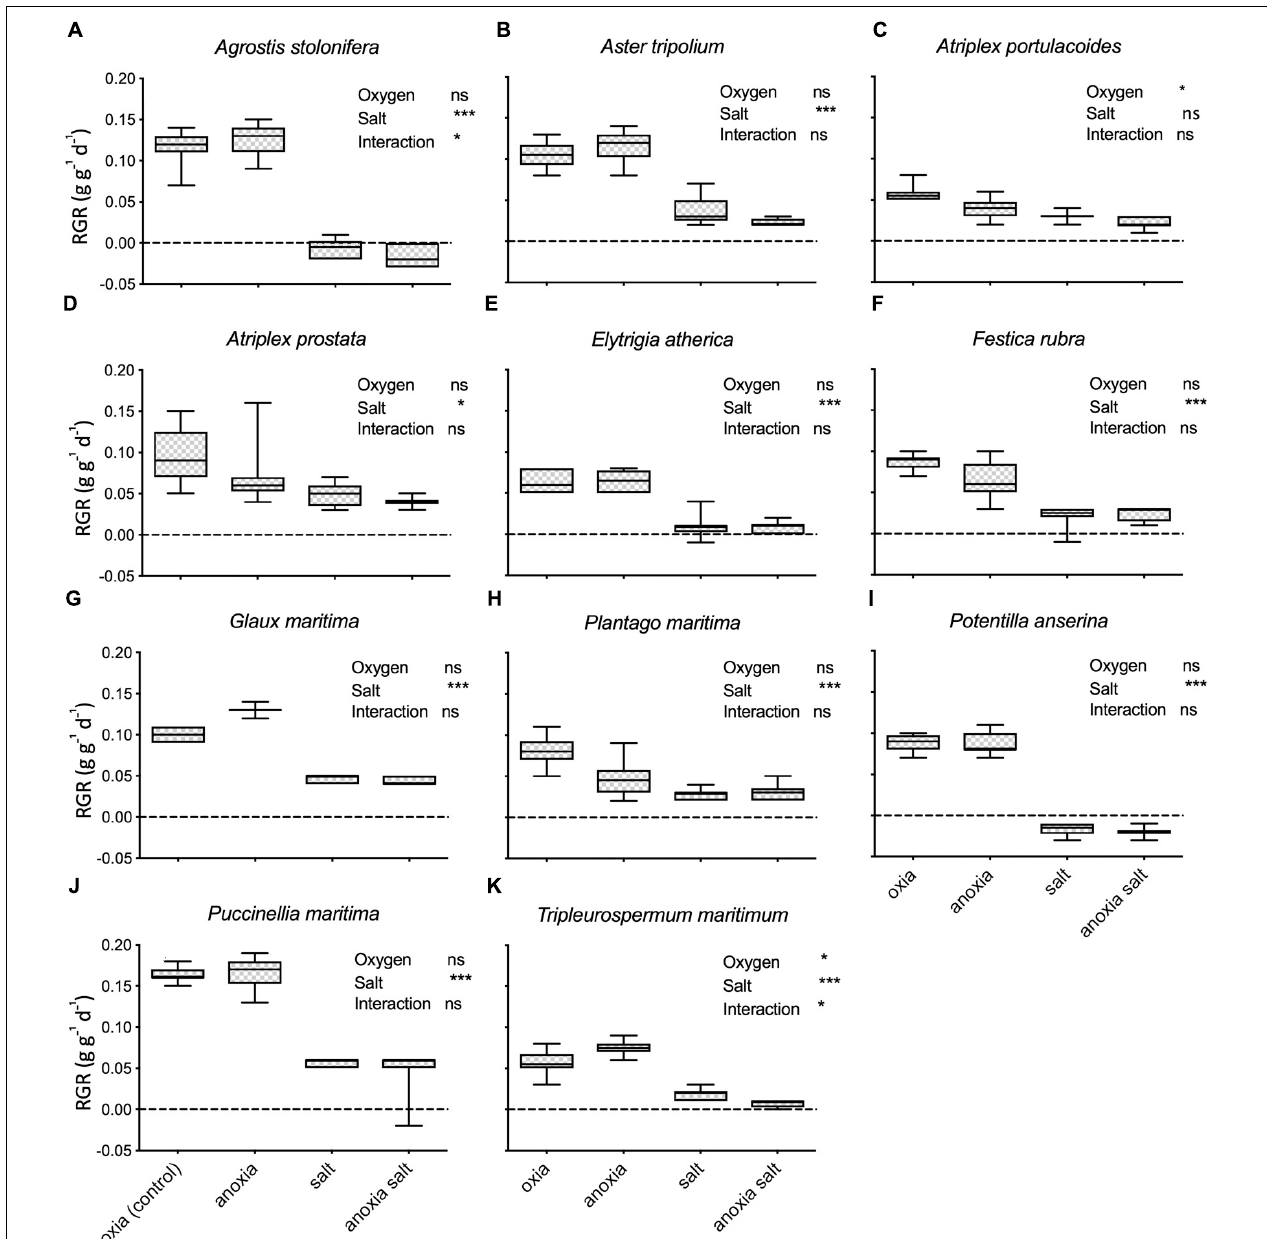
FIGURE 2 | FW Relative growth rates (g g - 1 d - 1 ; RGR) under different treatments of the glasshouse experiment. Each panel (A–K) represents one species. The RGR of 0 is marked with a black line. Treatments oxia and anoxia represent RGR from the oxygen experiment, n = 11–17 except for Salicornia europaea (oxia n = 4, anoxia n = 7). Treatments salt and anoxia salt represent RGR from the salt experiment, n = 4–9. The error bars denote 1SD. ∗ P < 0.05; ∗∗∗ P < 0.001; ns, not significant.